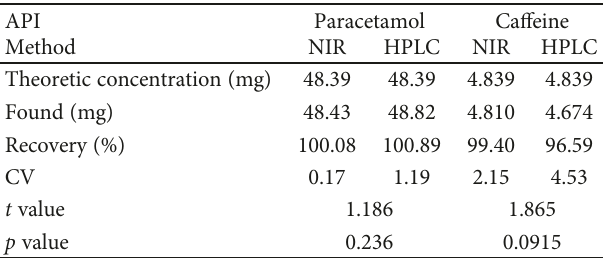
Figure 3: Accuracy pro fi le of the NIR — chemometic methods for paracetamol and ca ff eine determination. (a) paracetamol; (b) ca ff eine. Table 5: Paracetamol and ca ff eine determination by NIR-validated method and HPLC reference